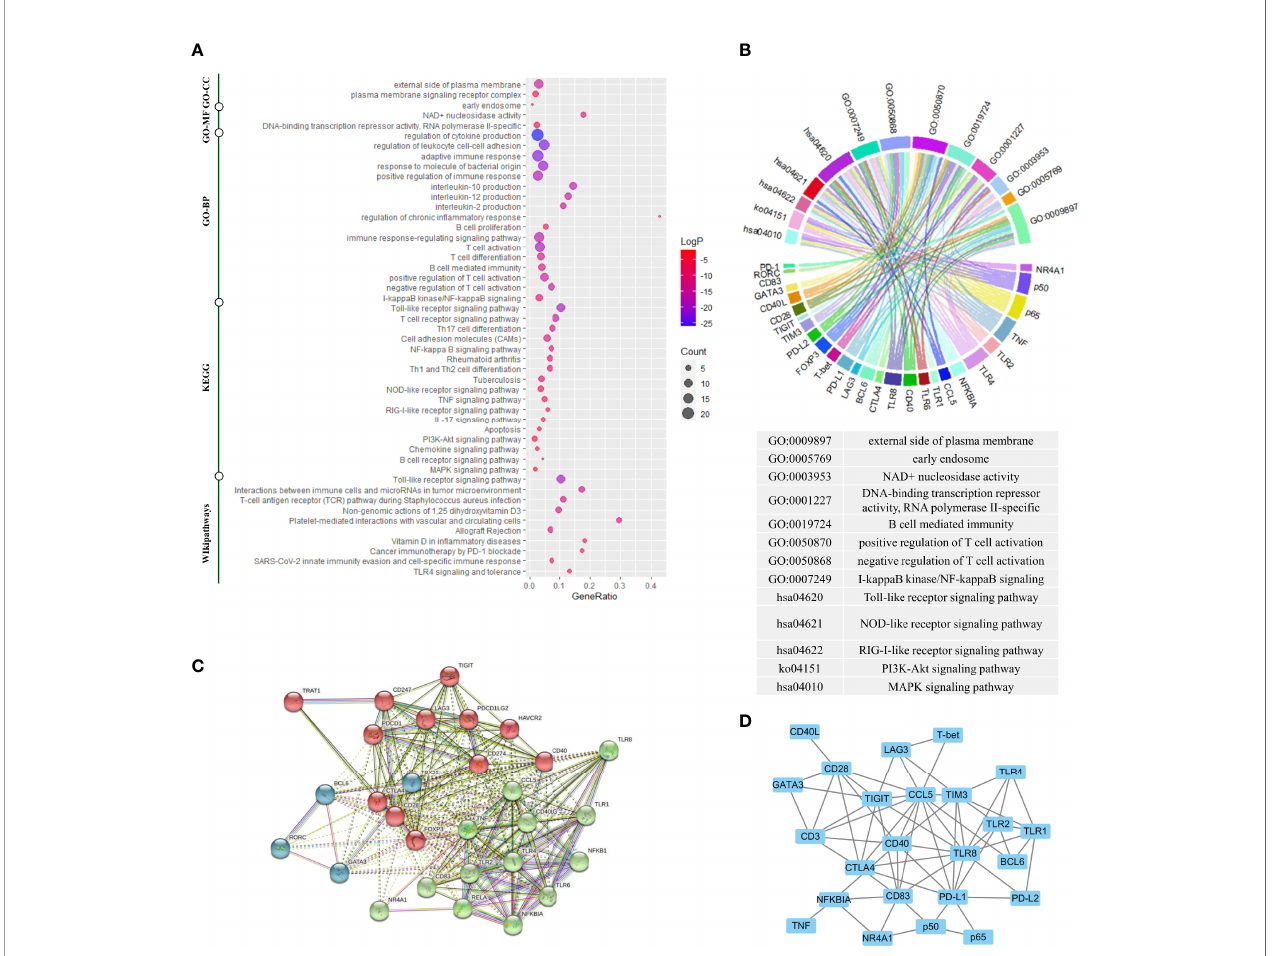
FIGURE 2 | Gene enrichment analysis, protein – protein interaction analysis, and gene co-expression analysis. (A) Gene enrichment analysis using multiple databases including the Kyoto Encyclopedia of Genes and Genomes (KEGG) database, the Gene Ontology (GO) database, and the WikiPathways database for targeted genes. (B) The genes corresponding to the enrichment results of GO analysis and KEGG analysis. (C) The protein – protein interaction (PPI) analysis based on the STRING database. (D) The gene co-expression analysis based on the COEXPEDIA database. Functional enrichment analysis indicated these genes were closely related to TLR signaling pathways and the function of the activation and differentiation of T-cells. PPI analysis and gene co-expression analysis indicated that there were strong associations among these genes, and experimental co-expression relationships would be compared with these database-interactions for newly discovered co- expression